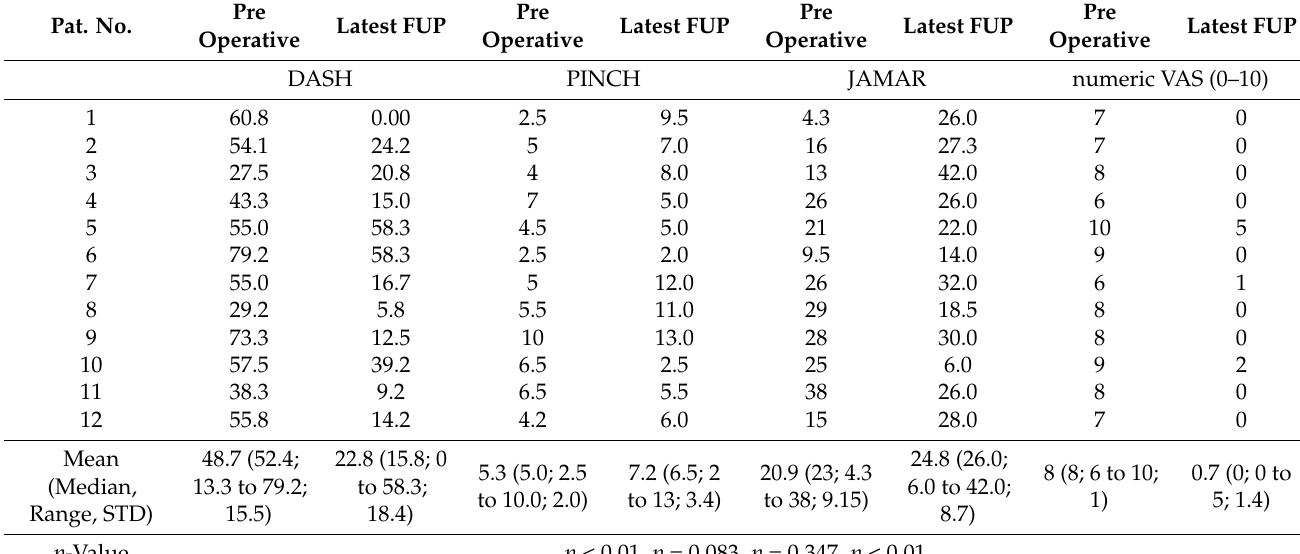
Table 3. Clinical outcome of patients pre- vs. latest